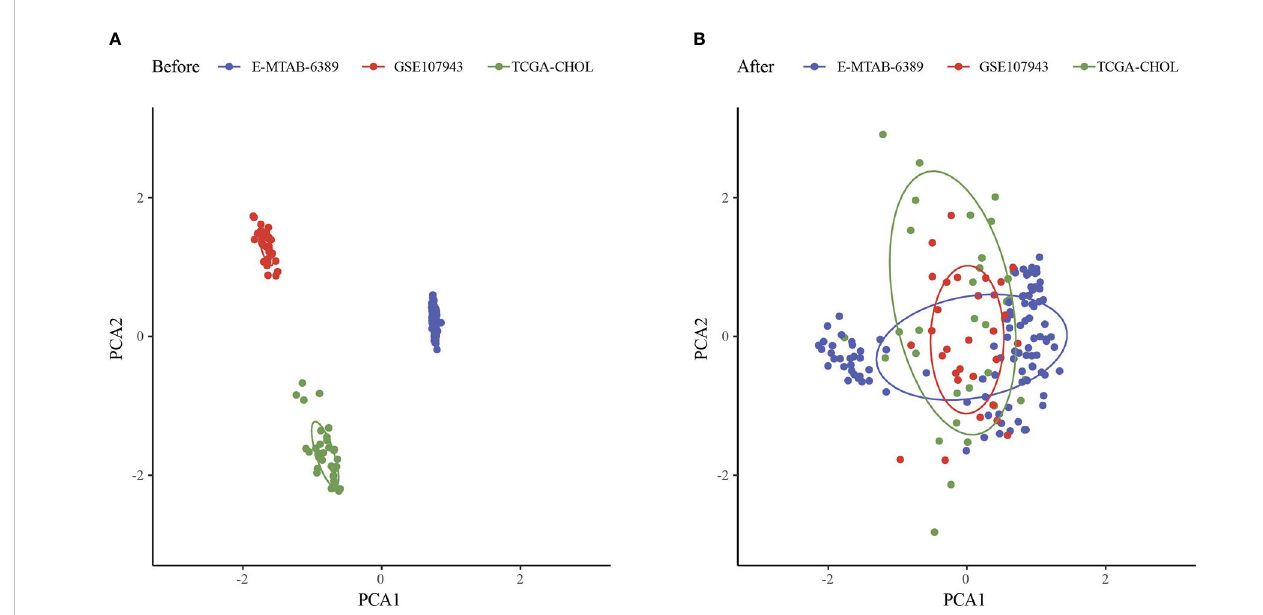
FIGURE 2 Principal component analysis. (A) PCA analysis before removal of batch effects. (B) PCA analysis after removal of batch